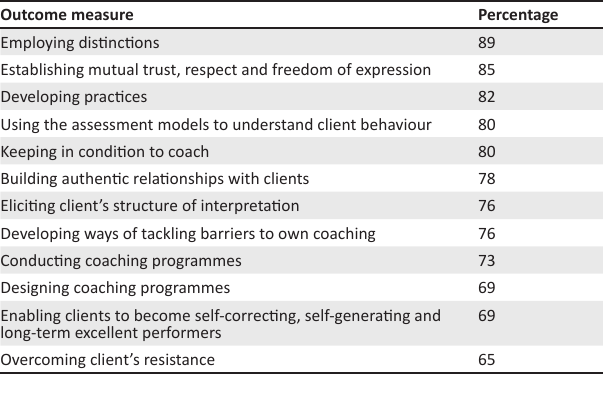
TABLE 3: Percentage of respondents scoring outcome measures with highest success.